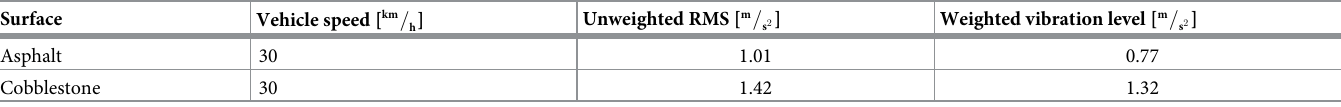
Table 3. Summarising acceleration values for compared automobile as unweighted RMS and weighted acceleration according to ISO 2631.